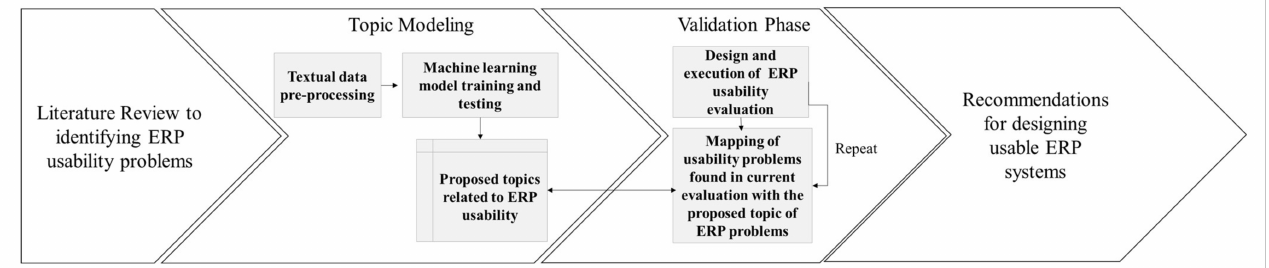
Figure 1. An approach for exploring usability problems in ERP